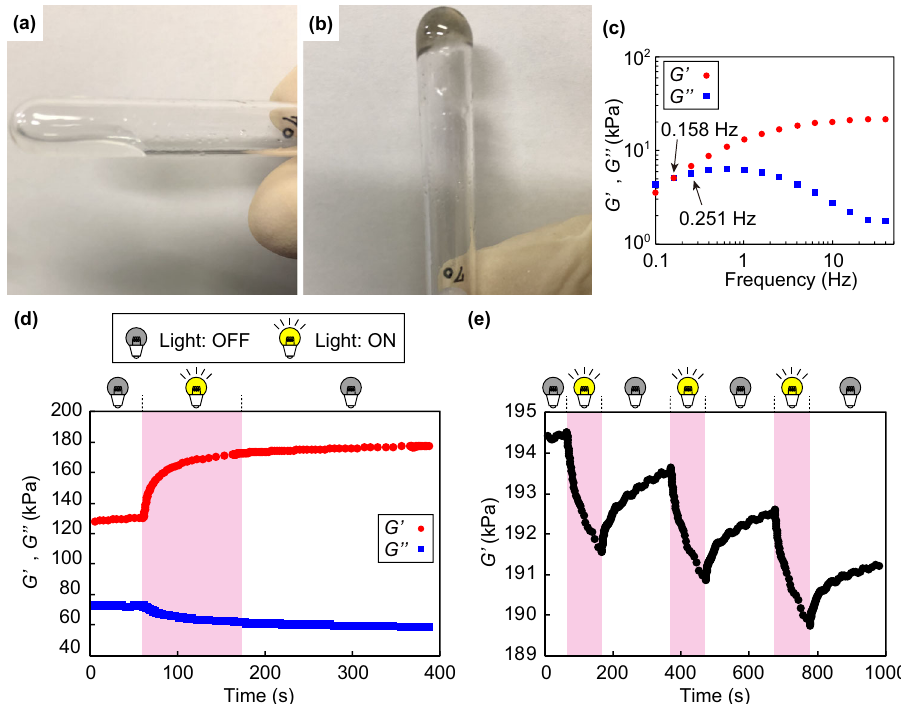
Fig. 5 Star-to-network electrochemical topological transformation. a , b Photographs of a mixture of S L and [EMI][TFSI] (weight ratio: S L /[EMI] [TFSI] = 70/30) ( a ) and IN 70 ( b ). c Frequency-dependent plots of G ′ and G ″ of IN 70 under the strain of 1%. d Time-course plots of G ′ and G ″ upon one- time photoirradiation (365 nm, 150 mW/cm 2 ) to IN 70 . e Time-dependent plots of G ′ upon ON – OFF cycles of photoirradiation to a sample after one-time photoirradiation to IN 70 . Photoirradiation was performed during time ranges indicated with pink shading and the measurements were conducted under the strain of 1% at the frequency of 5